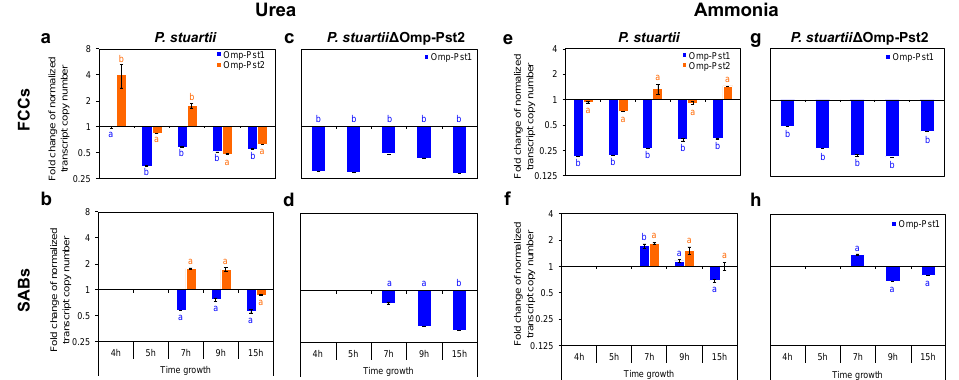
Figure 3. Presence of urea or ammonia induces a down-regulation of porin expression in P. stuartii . Expression of omp-pst1 (blue) and omp-pst2 (orange) porins in presence of 500 mM urea ( a – d ) or 500 mM ammonia ( e – h ) was monitored by RT-qPCR in both P. stuartii ( a , b , e , f ) or P. stuartii Δ Omp-Pst2 ( c , d , g , h ), at different stages of growth, and both in FCC (panel a , c , e , g ) and SAB ( b , d , f , h ). For each growth time point, we report the ratio of normalized transcript copy numbers between cells exposed and not exposed (control) to the cues. All measurements were performed in triplicates; errors bars outline standard deviations from the average. Different letters above the bars indicate significant differences ( p < 0.05; ANOVA followed by post-hoc Tukey HSD test; see statistical indicators in Supplementary Table S2).